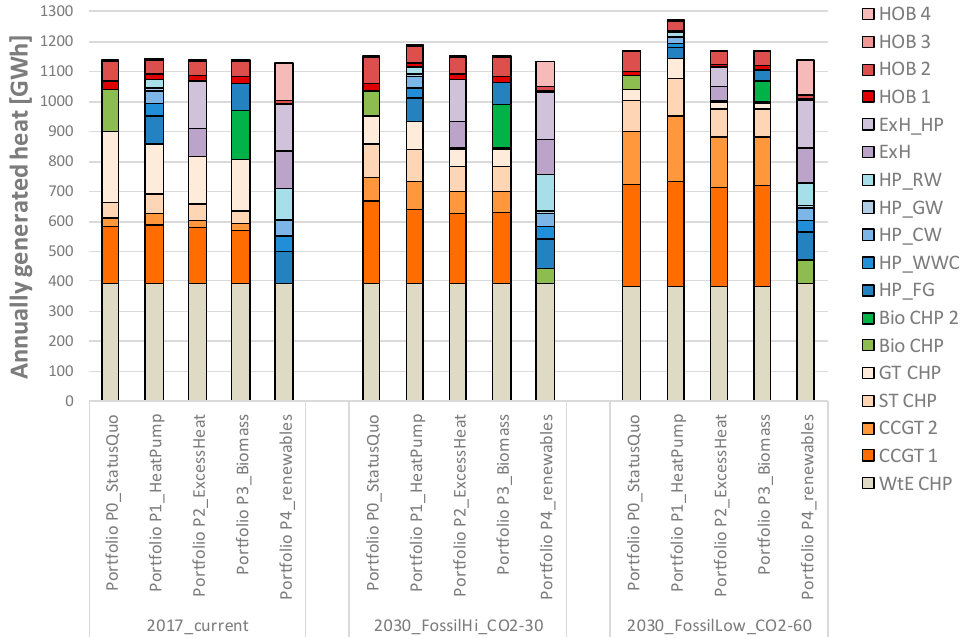
Figure 3. Comparison of annually generated heat of the different generation units for all scenarios and portfolios.